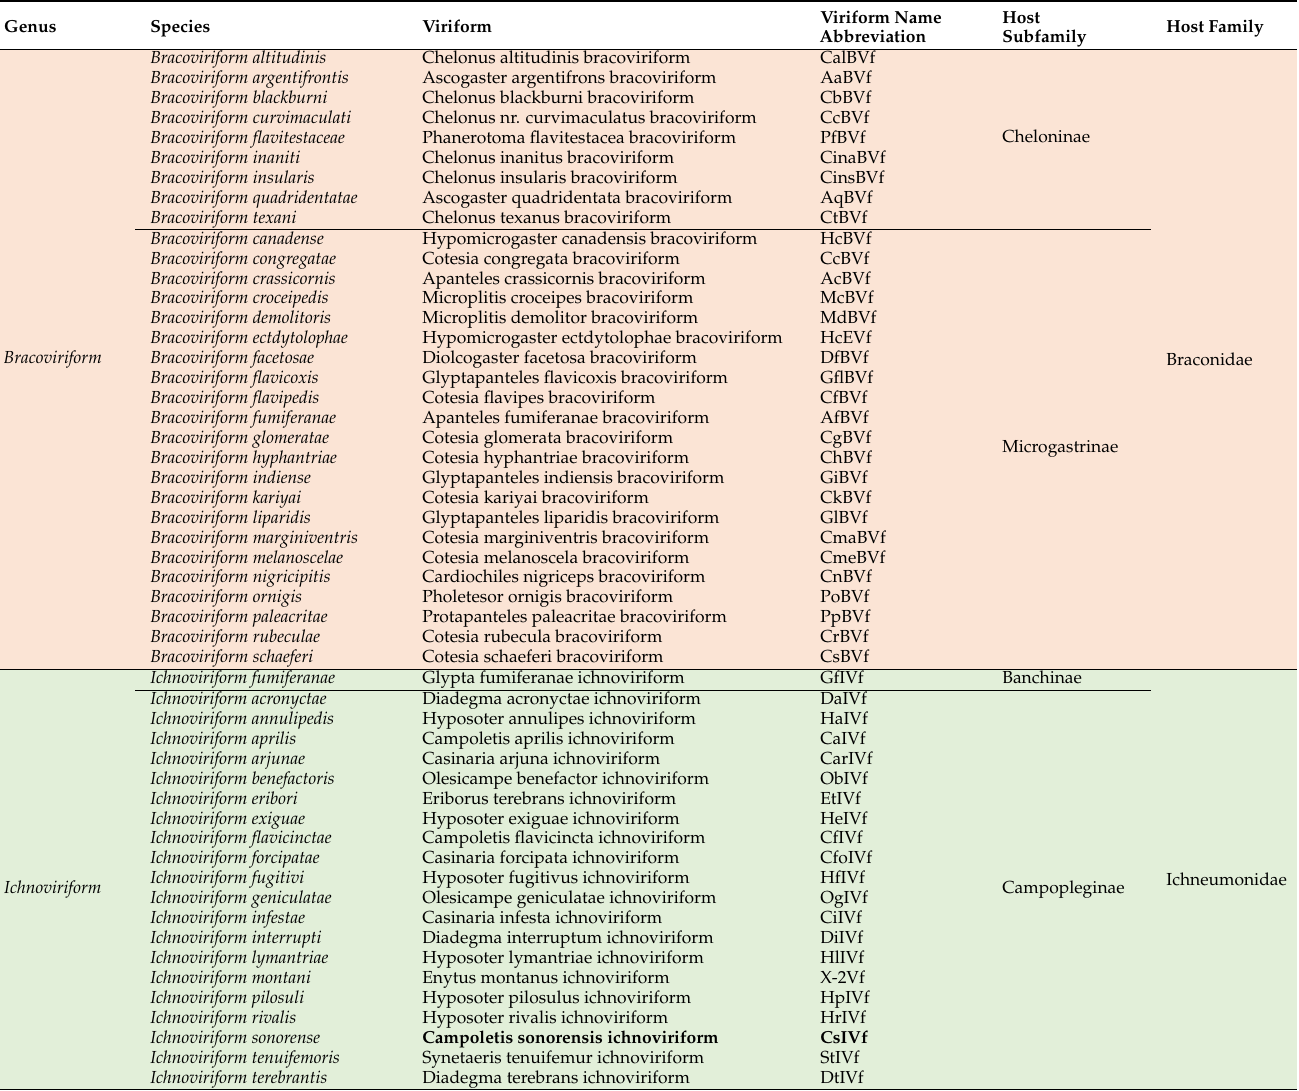
Table 1. 2022 taxonomy of family Polydnaviriformidae